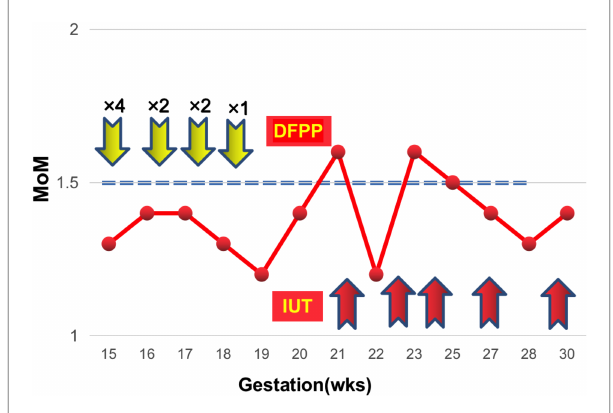
FIGURE 1 The fl uctuations of MoM during the whole treatment course (case 1). The yellow arrows denote the DFPP treatment session. The red arrows indicate